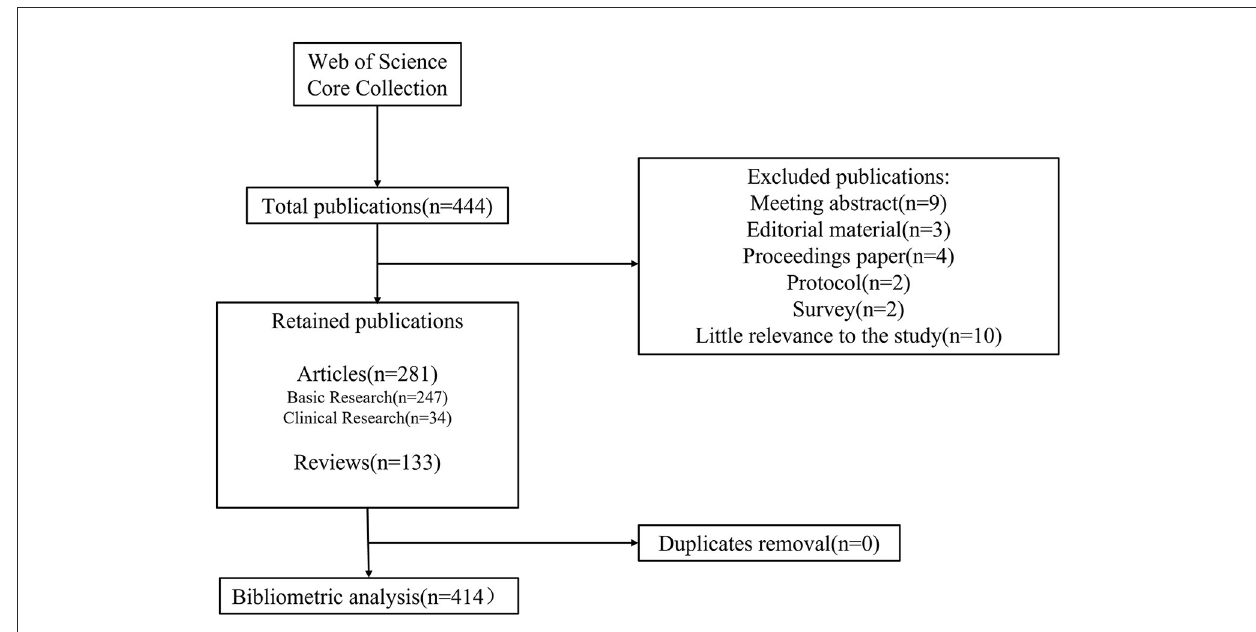
FIGURE1 Flow chart for literature